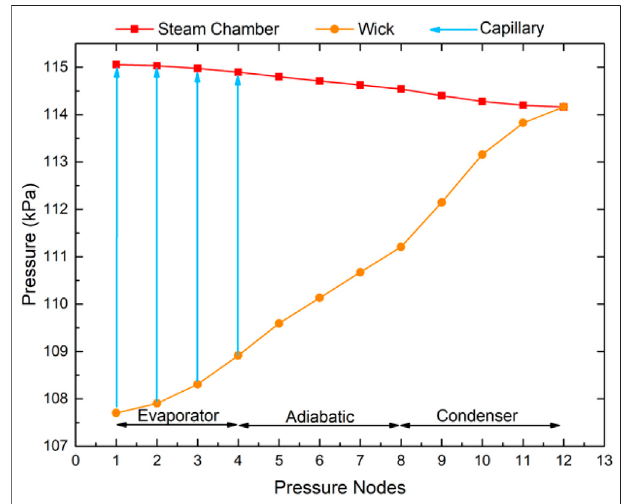
FIGURE 15 | Temperature distribution of the wall and the surface in the axial direction.